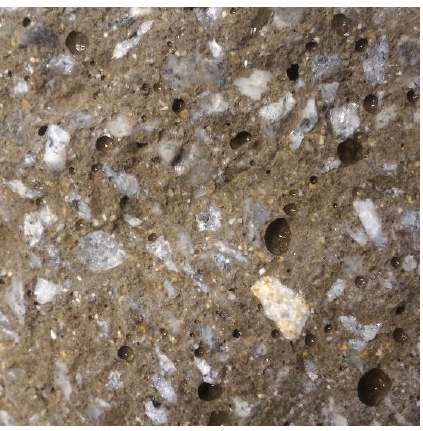
Figure 7. The fractured surface of GC26-mix with CAR =